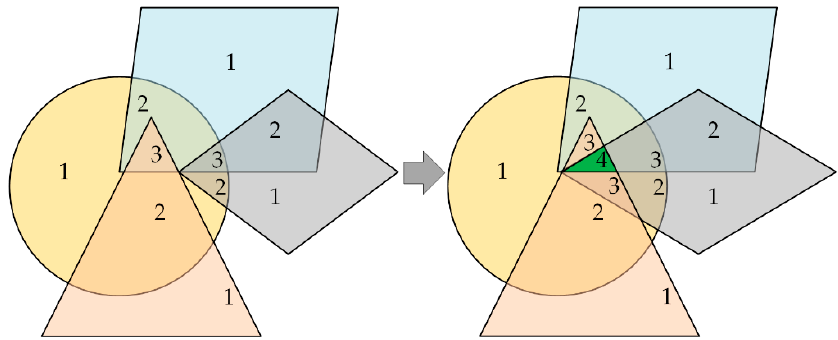
Figure 7. The coordination zone variation process by accuracy compensation.